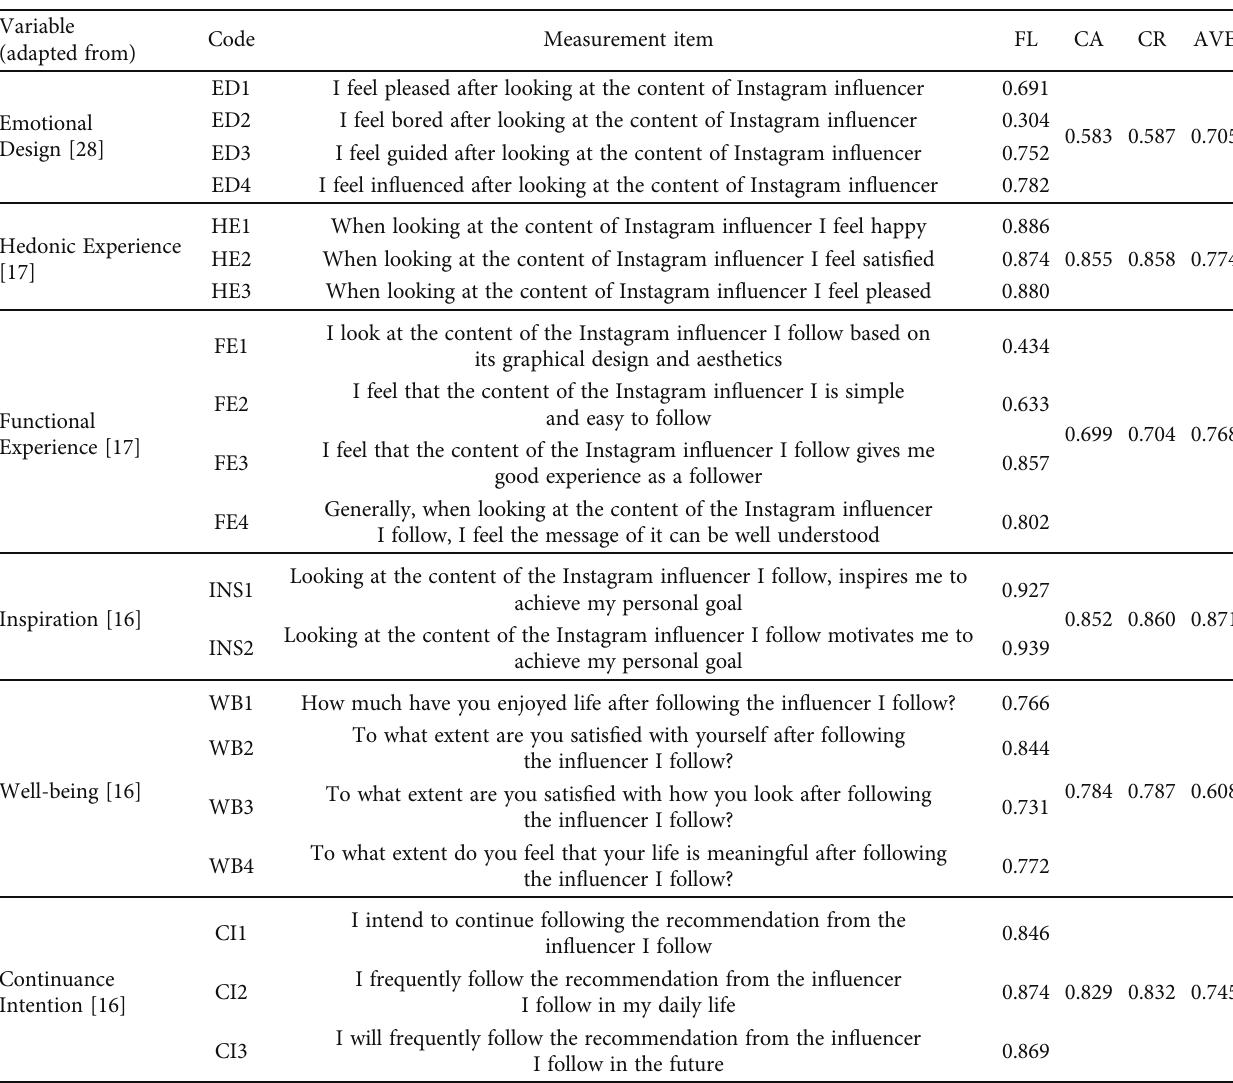
Table 2: Values of Factors Loading, Cronbach Alpha, Composite Reliability and Average Variance Extracted of the constructs and the measurement items.